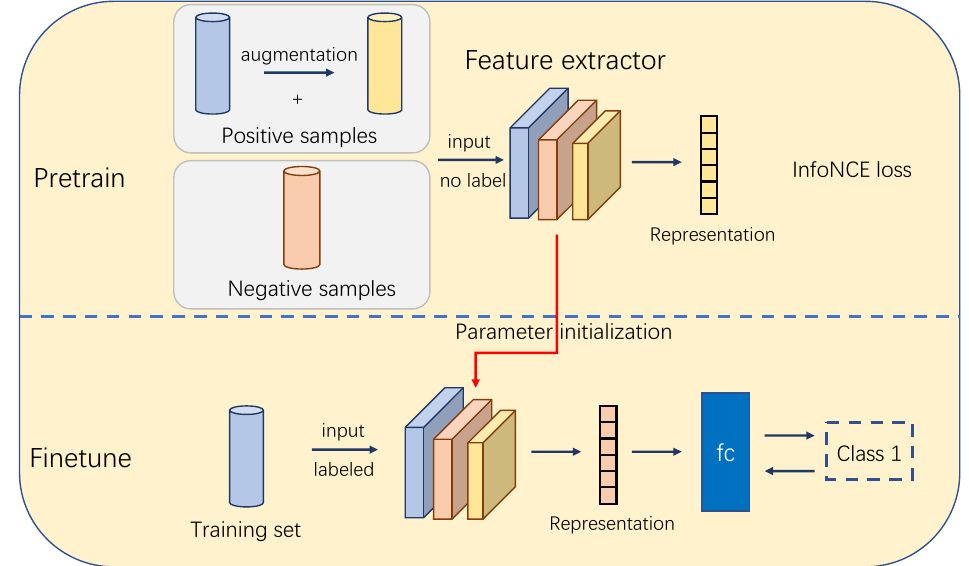
Figure 8. Contrastive learning and residual network framework. (1) In the upper part, we conduct pretraining based on contrastive learning, we perform data augmentation to generate positive samples, and the feature extractor is the residual network without FC layer. We use the InfoNCE loss function in this part. (2) In the bottom part, we initialize the feature extraction layer of the residual network with the pretrained model’s parameters, and the loss function is